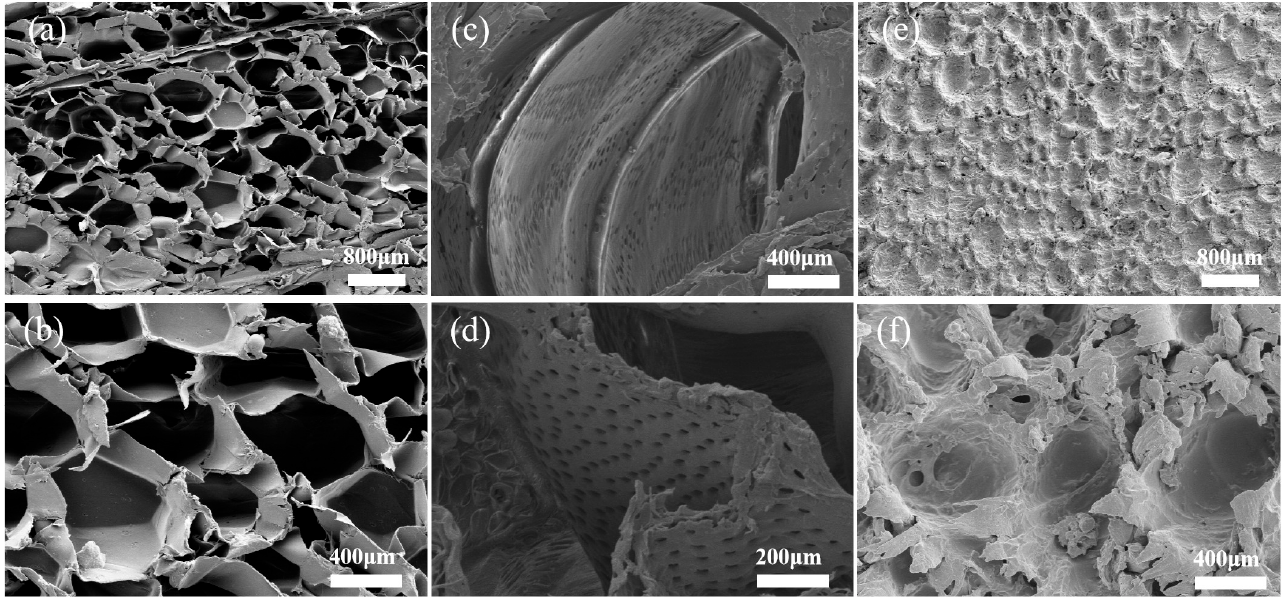
Figure 2. SEM images of natural wood (NW)at ( a ) low magnification, ( b ) high magnification, SEM images of “transparent wood” (DW-D-U) at ( c ) low magnification, ( d ) high magnification, SEM images of “transparent wood” (TW-D-U) at ( e ) low magnification, ( f ) high magnification.